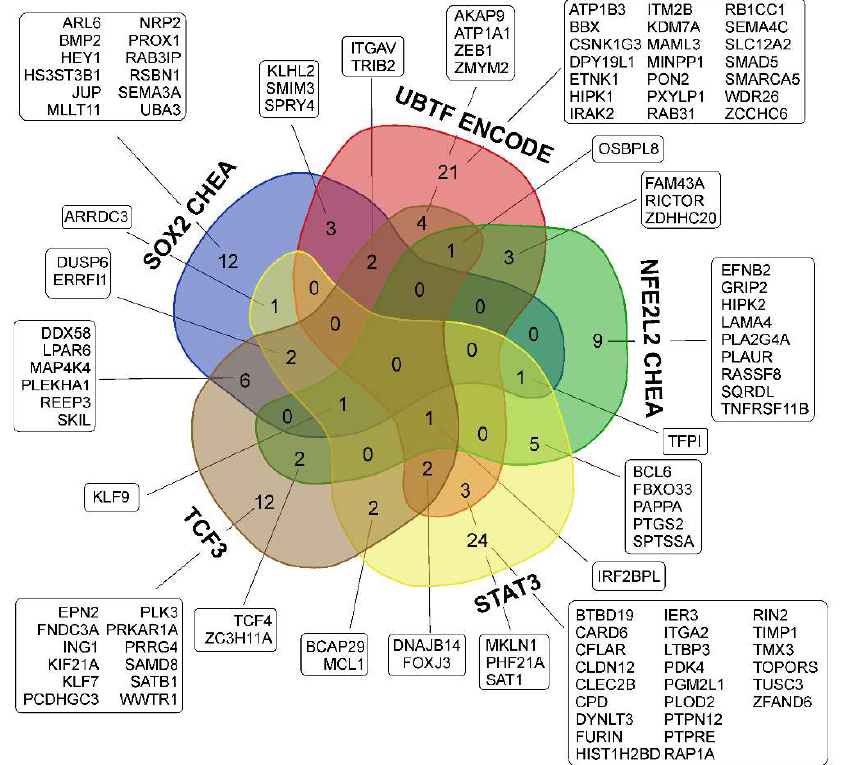
Figure 5. Venn diagram showing intersections of sets of glioma NS upregulated genes controlled by SOX2, UBTF, NFE2L2, STAT3 and TCF3 transcription factors. Glioma NS upregulated genes analyzed using Enrichr library “ENCODE and ChEA Consensus TFs from ChIP-X”. STAT3 controlled genes from the Enrichr library “ENCODE TF ChIP-seq 2015” concerning overlap with “STAT3 HeLa-S3 hg19” gene list. TCF3-dependent genes from the union of “TCF3 ENCODE” and “TCF3 CHEA” Enrichr libraries “ENCODE and ChEA Consensus TFs from ChIP-X”.